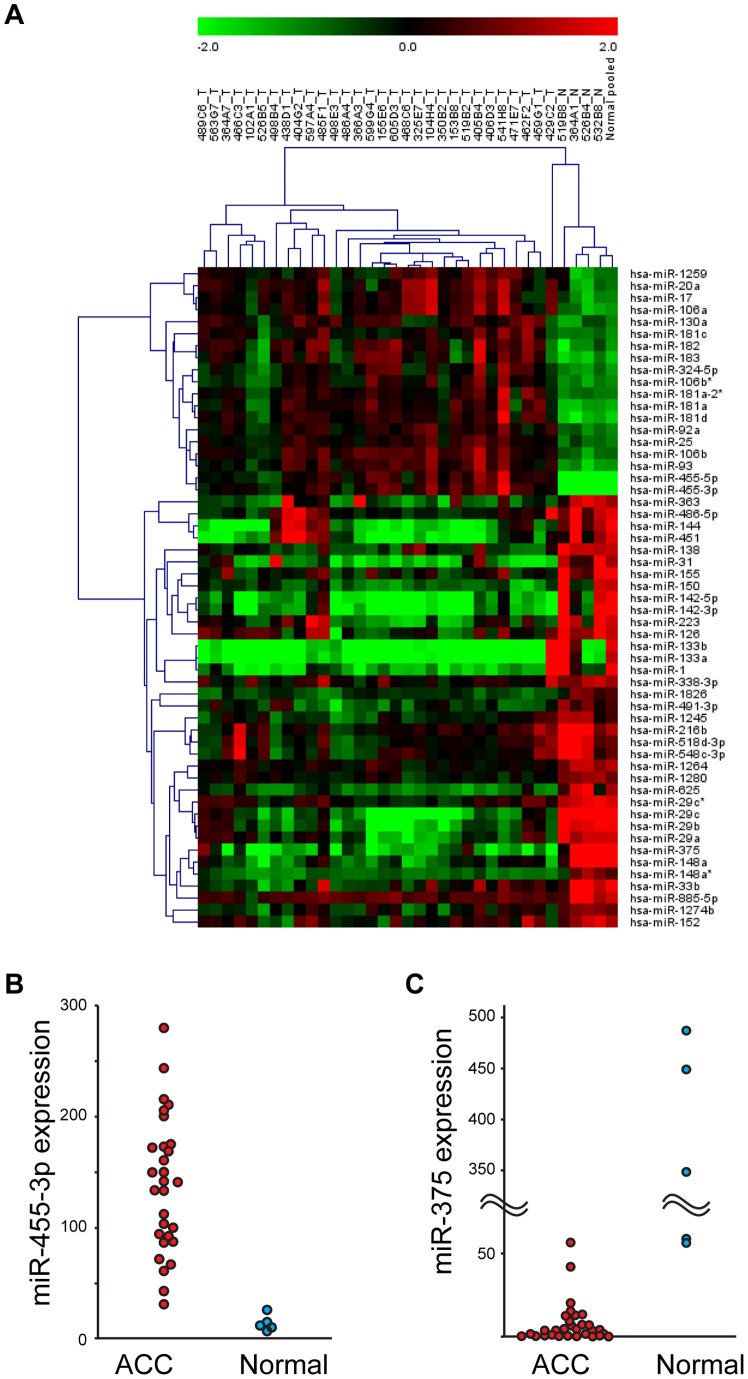
MiRNA expression differences in salivary ACCs and normals.(A) A heat map of the differential miRNA expression in normal salivary tissues and control versus tumor samples. Note the clean distinction between normal tumors. Quantitative RT-PCR validation of miRNA expression, miR-455-3p (B) and miR-375 (C).